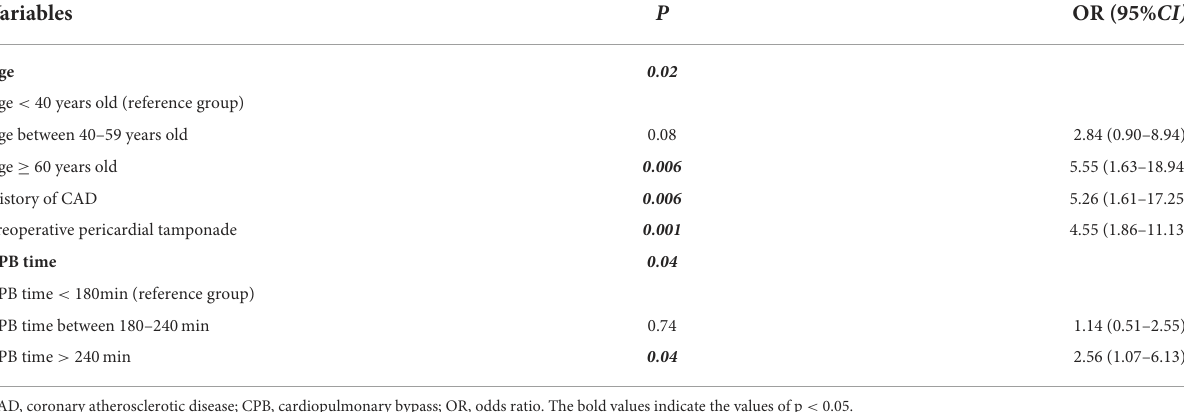
TABLE 6 The results of multivariate logistic regression analysis showing the independent risk factors of EF reduction in patients with AKI undergoing CRRT after ATAAD surgery.